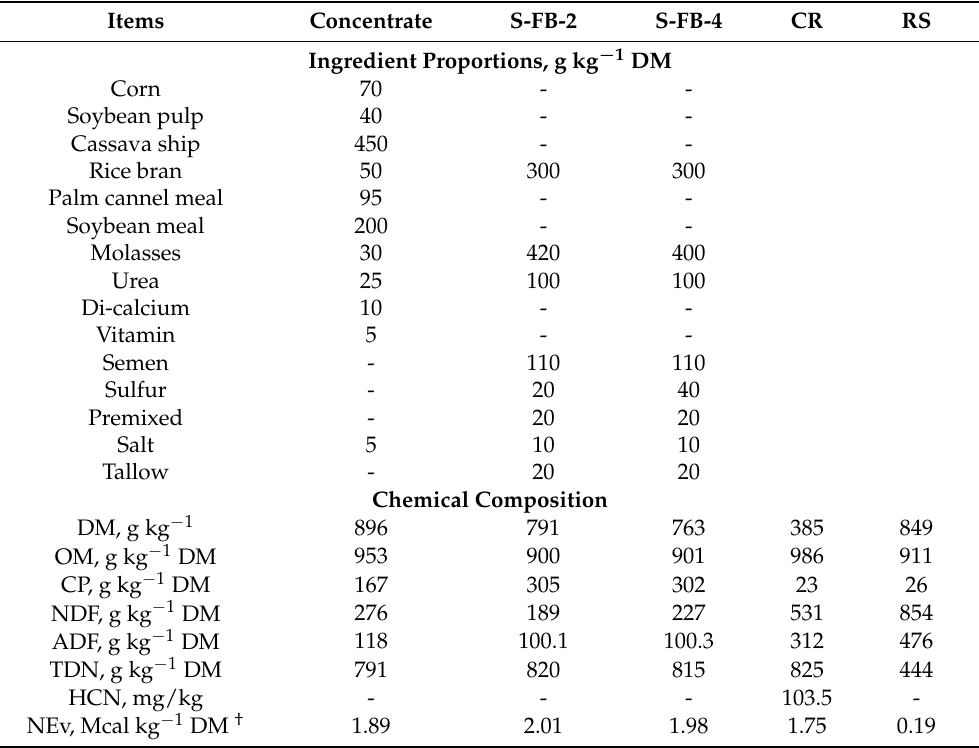
Table 1. Ingredients and chemical composition of concentrate, solid feed-block, fresh cassava root (CR), and rice straw